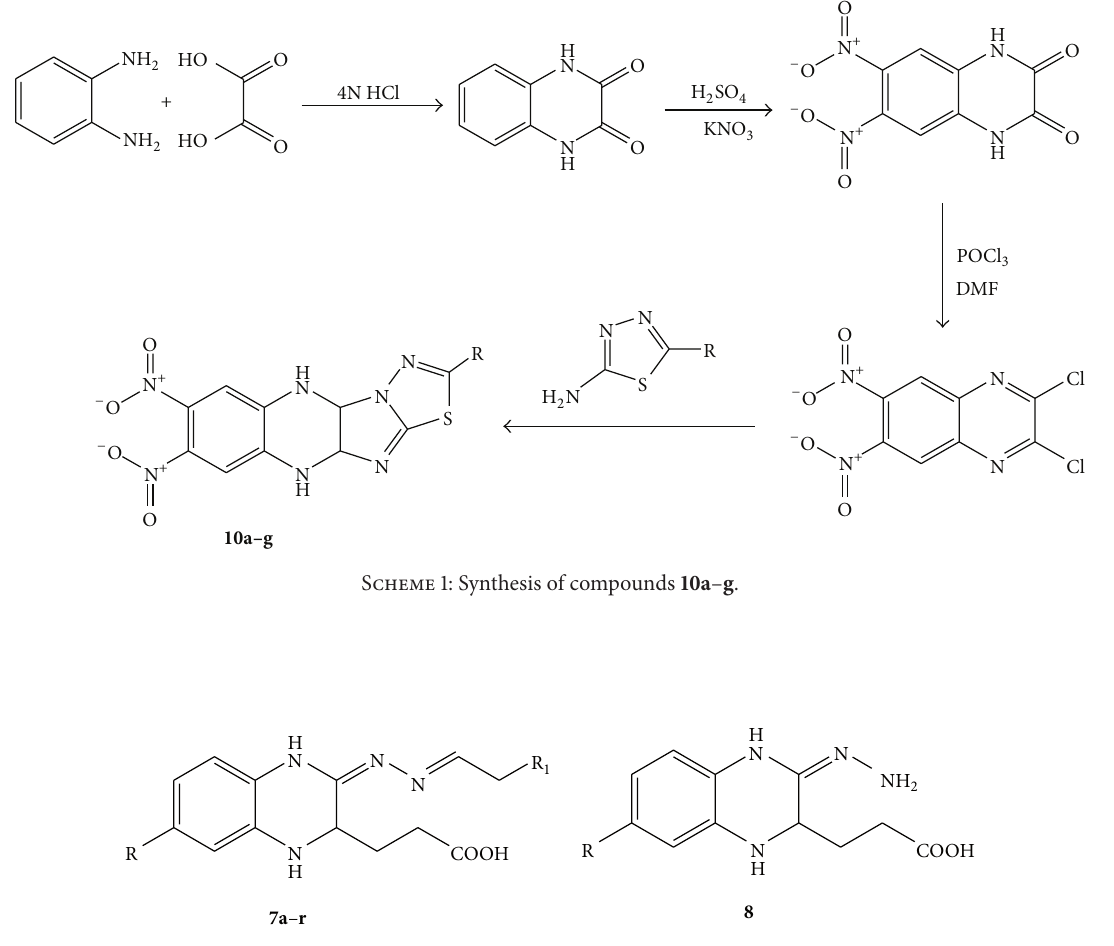
Figure 3: Chemical structures of compounds